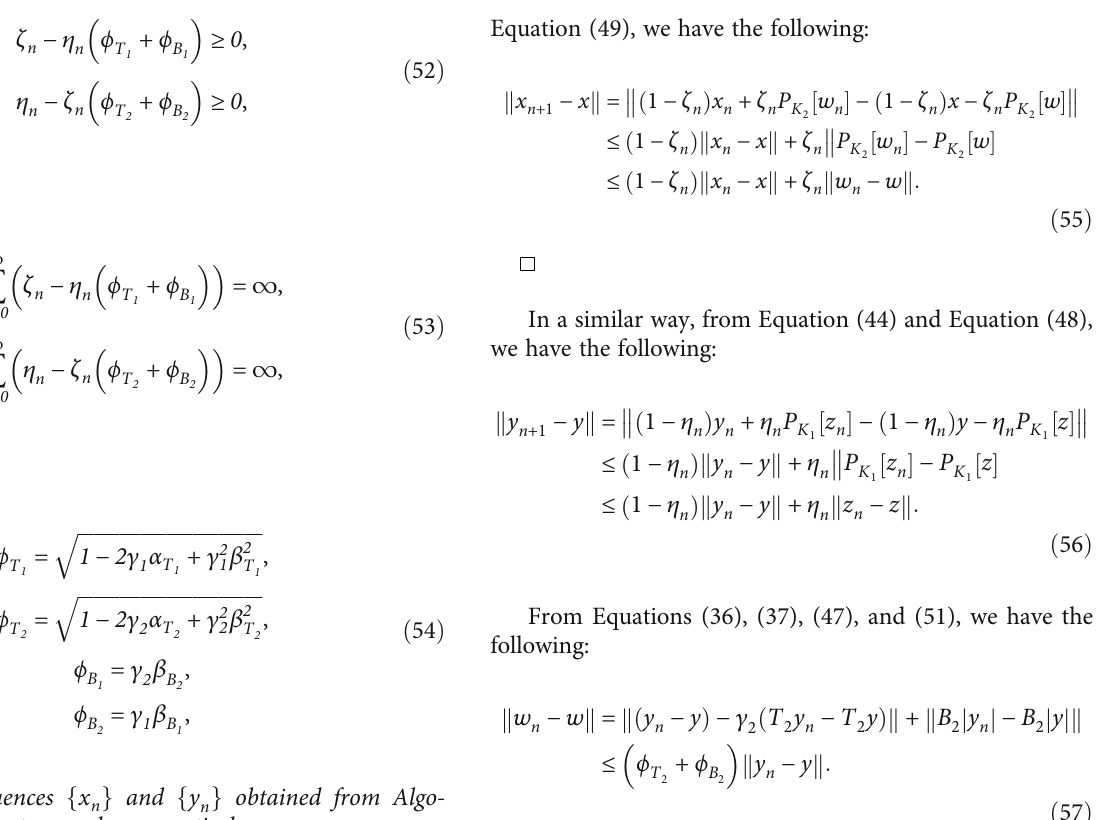
x Þ , T x Þ , B x Þ , and B 1 ð 2 ð 1 ð